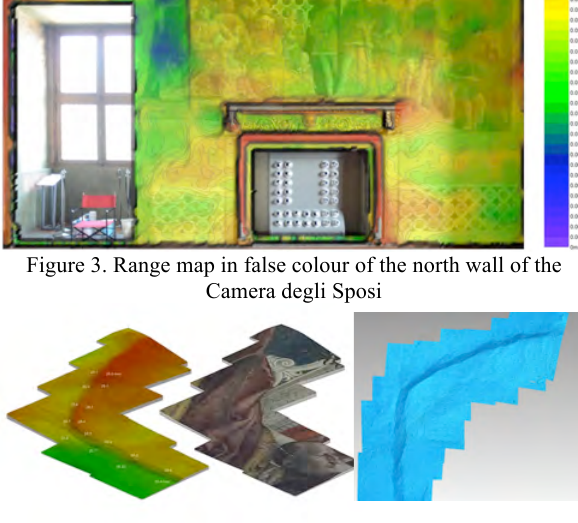
Figure 4. Detailed DSM of the